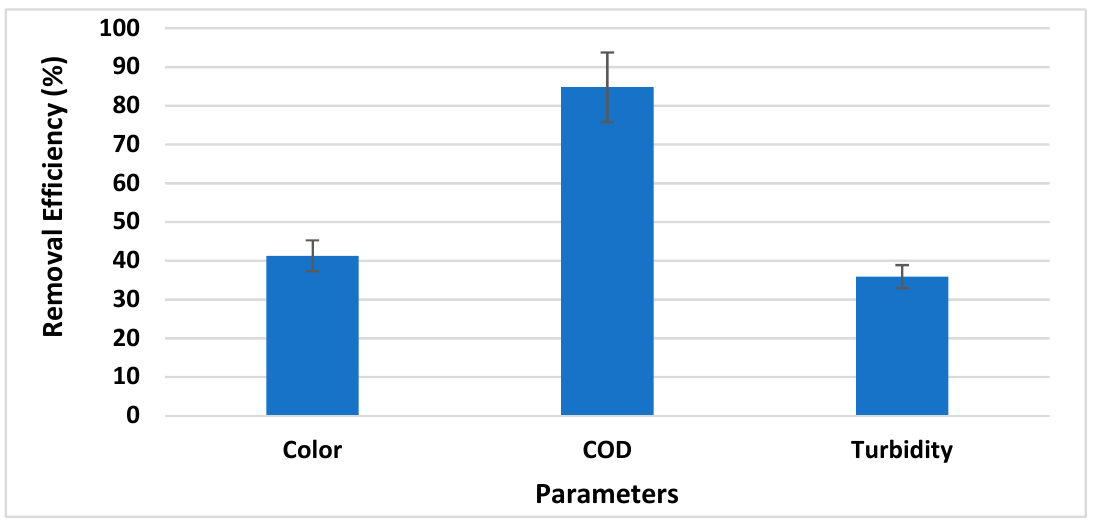
Figure 5. Ozone treatment of chemically treated wastewater and removal efficiencies (%) for color, COD and turbidity. Means values are presented in graphs with standard deviation.